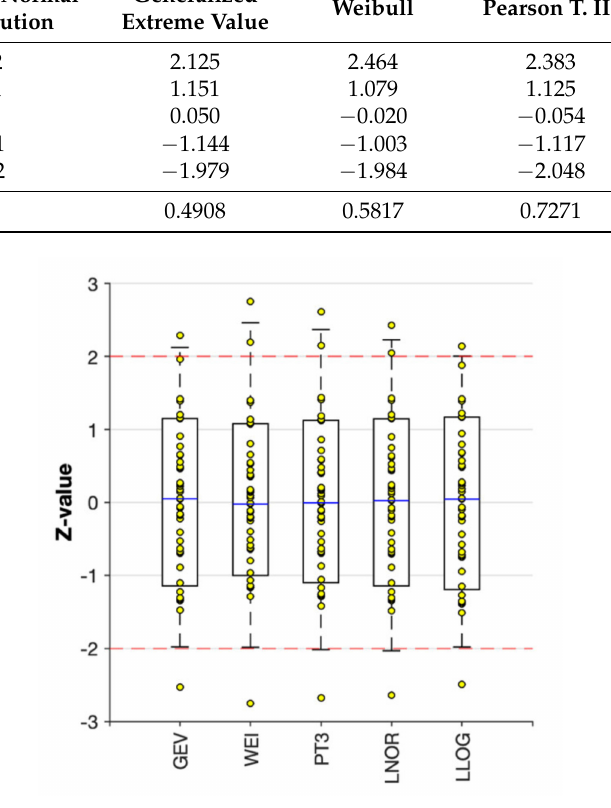
Figure 6. Modified boxplots showing the standardized distributions computed for the 6-h rainfall time series of R1 rain gauge, using different probability functions (generalized extreme value, Weibull, Pearson Type III, lognormal and loglogistic). A perfect fit provides a median equal to zero (Z = 0), box width between Z = 1 and Z = − 1 and whisker extent up to Z = 2 and Z = − 2. Yellow circles are the standardized data, and the blue line is the median of the